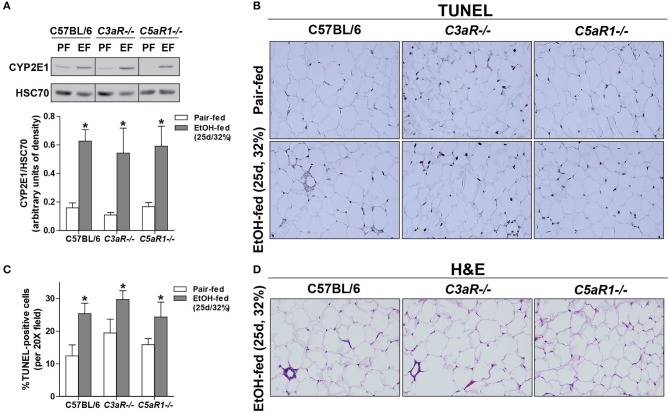
Chronic ethanol feeding leads to CYP2E1 induction and accumulation of TUNEL-positive cells in gonadal adipose tissue. WT, C3aR−/−, and C5aR1−/− mice were allowed free access to ethanol (32%, d25) or pair-fed control diets. (A) Adipose lysates were prepared and proteins separated by SDS-PAGE. CYP2E1 and HSC70 (loading control) were measured by Western blot. Relative expression is denoted as arbitrary units of density. (B) Apoptotic cells were visualized in paraffin-embedded gonadal adipose sections. (C) TUNEL-positive cells were enumerated and expressed as a percent of the total hematoxylin-positive nuclei/20x field. All images were quantified from at least three images per slide. (D) Paraffin-embedded gonadal adipose sections were deparaffinized followed by staining with hematoxylin and eosin. Values represent means ± SEM, values with * were significantly different from pair-fed controls within genotype (P<0.05). n = 4–8 pair-fed and 6–8 EtOH-fed mice.